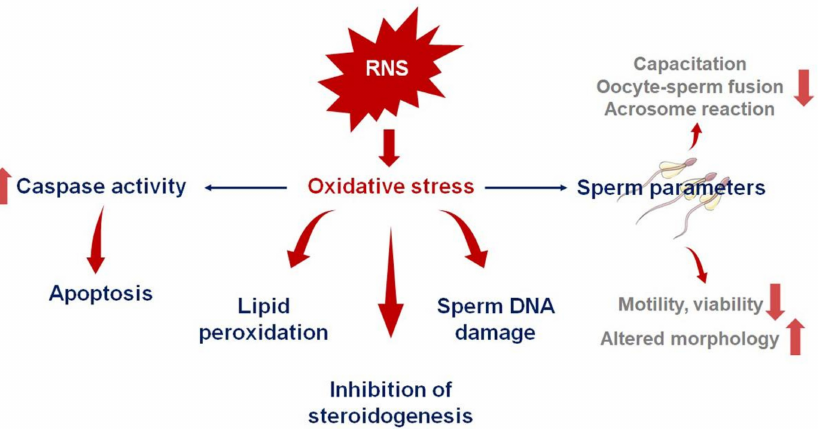
Figure 3. Detrimental role of reactive nitrogen species (RNS). This figure illustrates the harmful role RNS plays in the human body. At toxic levels, RNS can cause a variety of pathological effects on sperm parameters and normal cellular